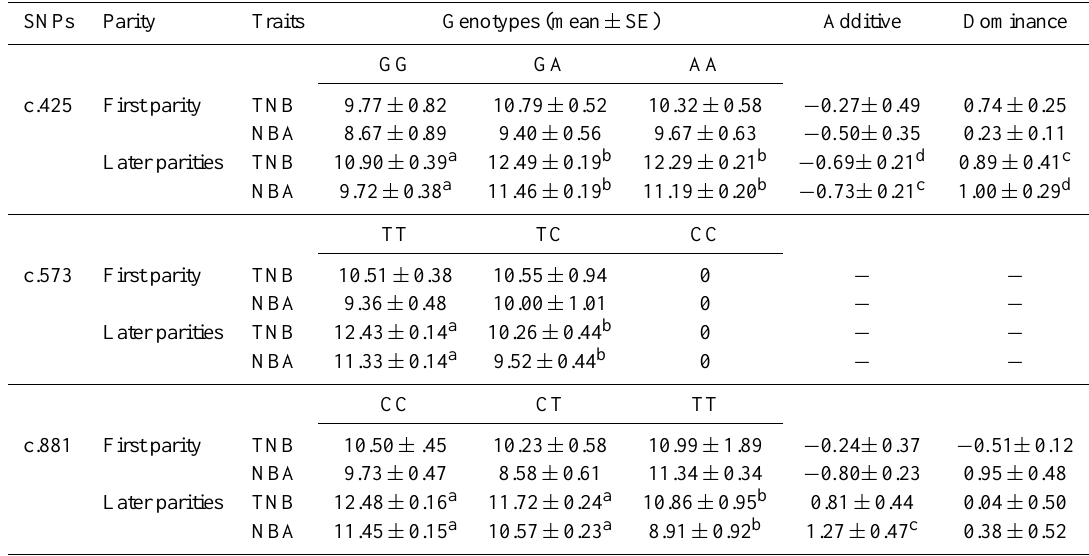
Table 3. Association of the porcine OPN gene with litter size traits. SNPs Parity